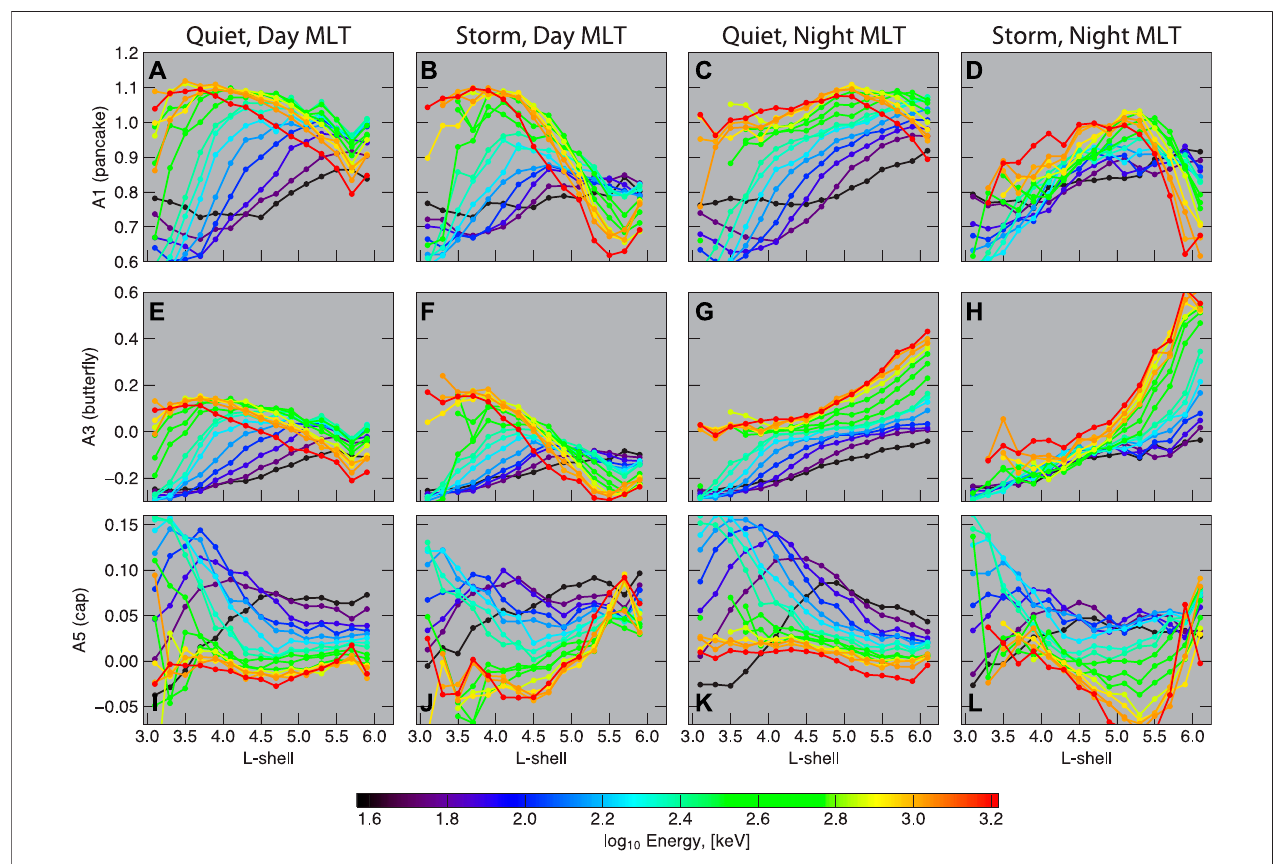
FIGURE 5 | Energy dependence of the PAD shape coef fi cients for pre-storm and main phase conditions at day and night MLT sectors.